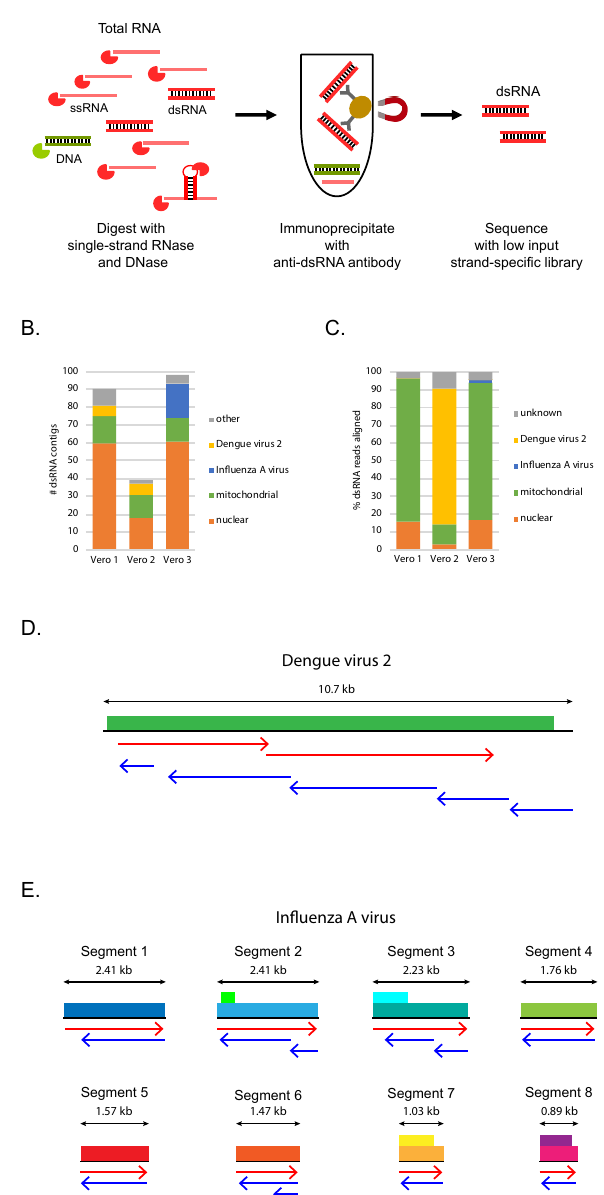
Figure 1. dsRNA-Seq detects viral infections of cultured mammalian cells. ( A ) Outline of the dsRNA purification method; ( B ) number of dsRNA contigs assembled from dsRNA-Seq reads from infected or mock infected Vero cell samples and their classification based on mapping to host nuclear or mitochondrial chromosomes or BLASTn analysis against NCBI nt; ( C ) percentage of dsRNA-Seq reads that align to the host nuclear or mitochondrial chromosomes, influenza A viral genome, dengue virus type 2 genome, or did not align (unknown). For ( D ) and ( E ), viral genomes are illustrated with protein coding regions indicated by colored boxes. Arrows indicate the alignment of contigs to viral genomes or genome segments. Contigs representing the positive strand are in red; negative strand in blue; ( D ) alignment of contigs assembled from Vero 2 sample to dengue virus type 2 genome; ( E ) alignment of contigs assembled from Vero 3 sample to influenza A viral